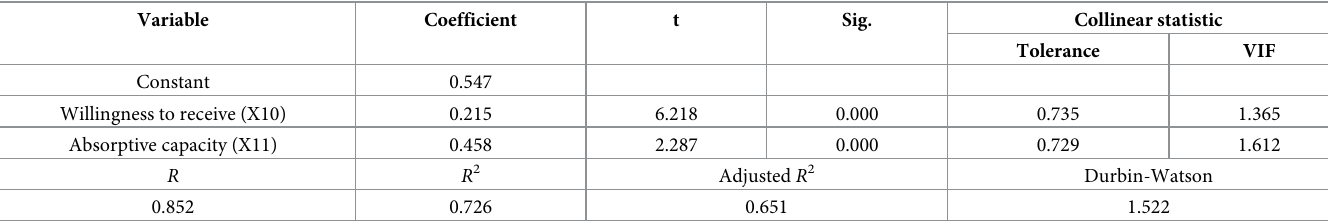
Table 15. Classified regression analysis results of knowledge receivers and knowledge transfer performance.